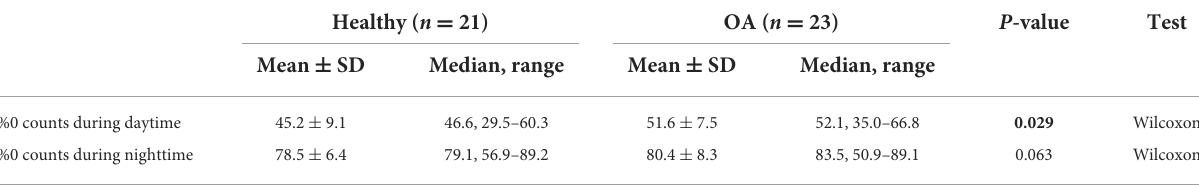
TABLE 3 Percentage of PetPace reported epochs that returned zero activity counts during daytime and nighttime. Healthy ( n = 21) OA ( n = 23) P -value Mean ± SD Mean ± SD